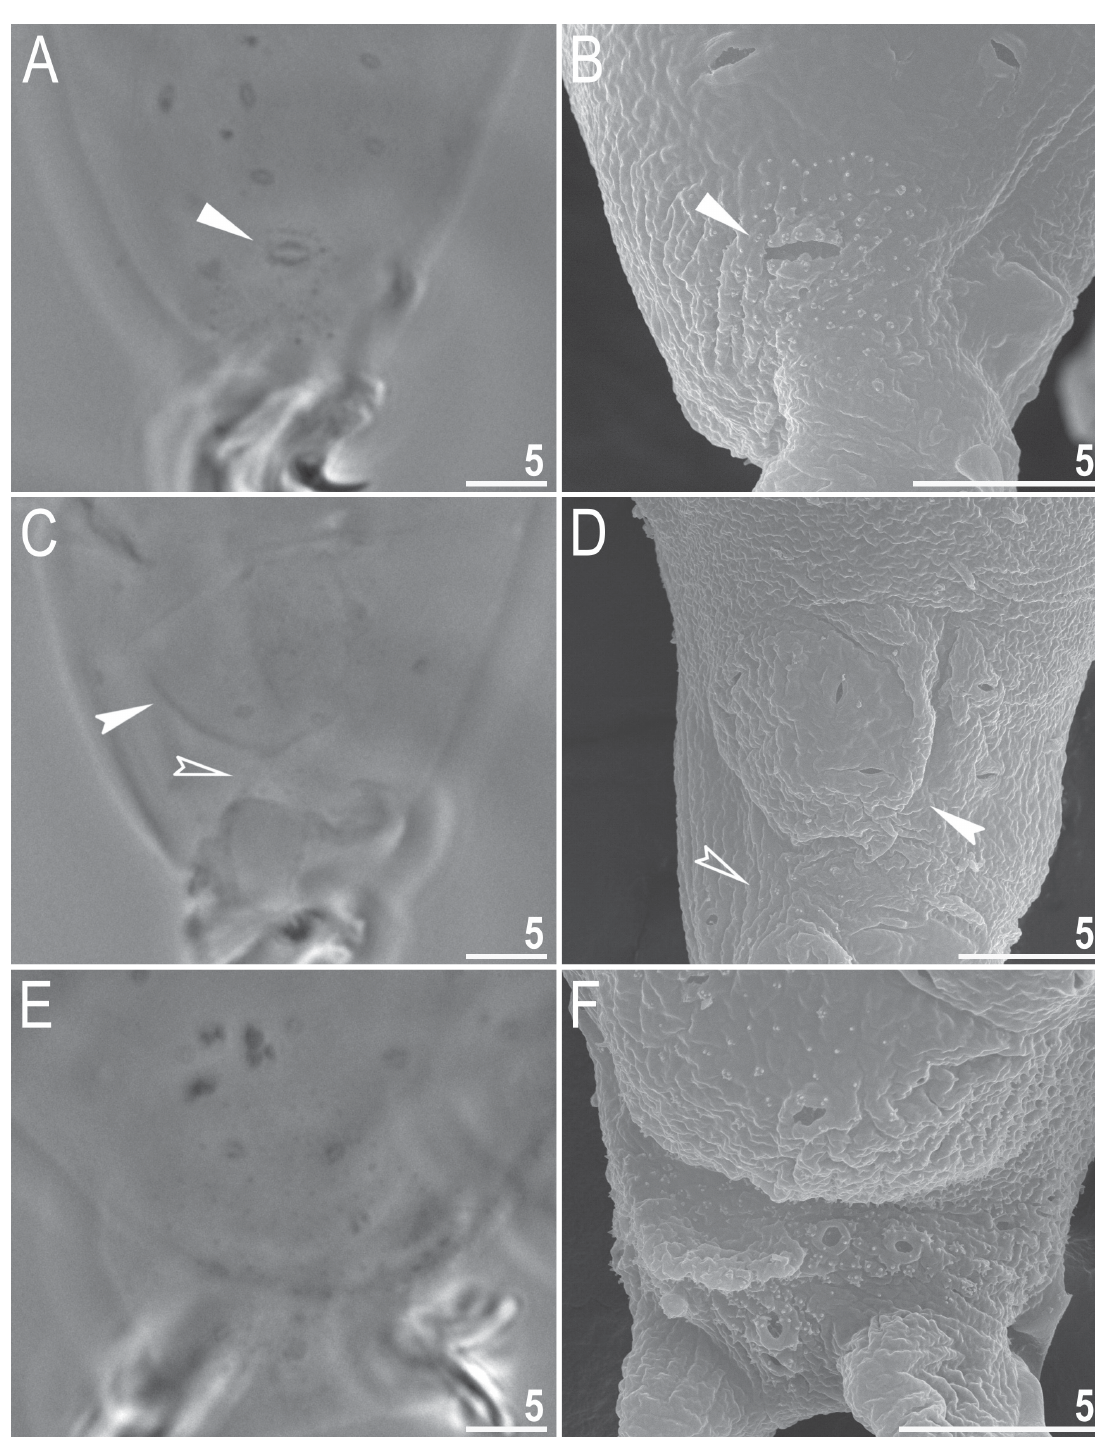
Fig. 3. Macrobiotus canaricus sp. nov., paratypes, cuticular structures on legs. A–B . The patch of granulation on the external surface of leg III with a large oval cuticular pore at the centre of the patch (PCM and SEM, respectively). C–D . The patch of granulation and the cuticular bulge (pulvinus) on the internal surface of leg II (PCM and SEM, respectively). E–F . Granulation on leg IV (PCM and SEM, respectively). Filled flat arrowheads indicate the large pore in the centre of the external granulation patch, filled indented arrowheads indicate the cuticular fold (pulvinus) on the internal leg surface, and empty indented arrowheads indicate granulation on the internal leg surface. Scale bars in